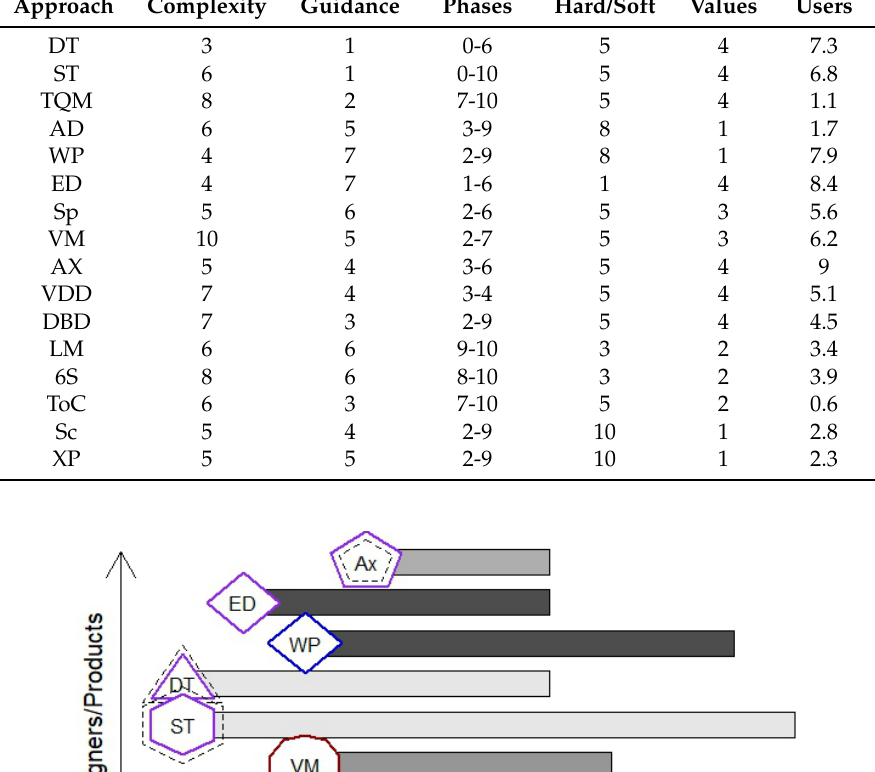
Table 6. Authors’ classifications of approaches from Table 1 within criteria from Table 5.